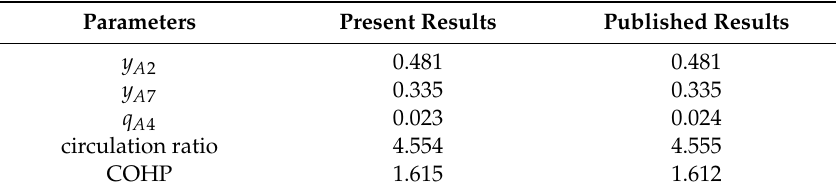
Table 8. Comparison between the simulated results and the published data for ammonia-water based AHP.